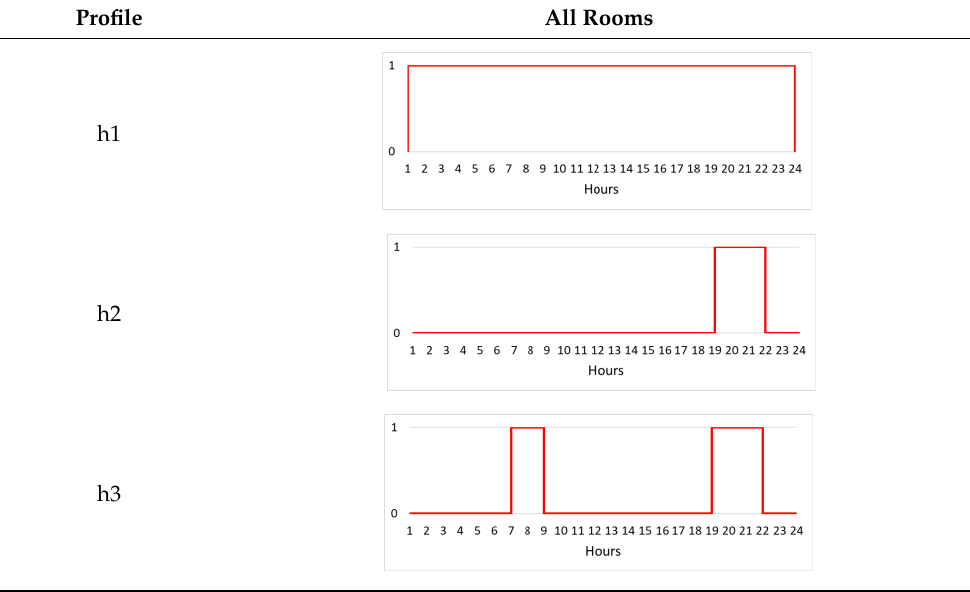
Table 2. Daily heating schedules (On = 1, Off = 0). Adapted from [33].